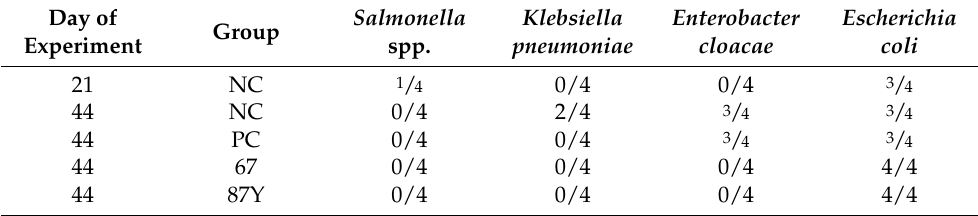
Table 3. Detection of the microorganisms found within amplified cecal material using RAPID Salmonella agar. NC, negative control; PC, birds receiving 3% addition of unfermented rapeseed meal (URSM); 67, birds receiving 3% addition of FRSM by B. subtilis 67; 87Y, birds receiving 3% addition